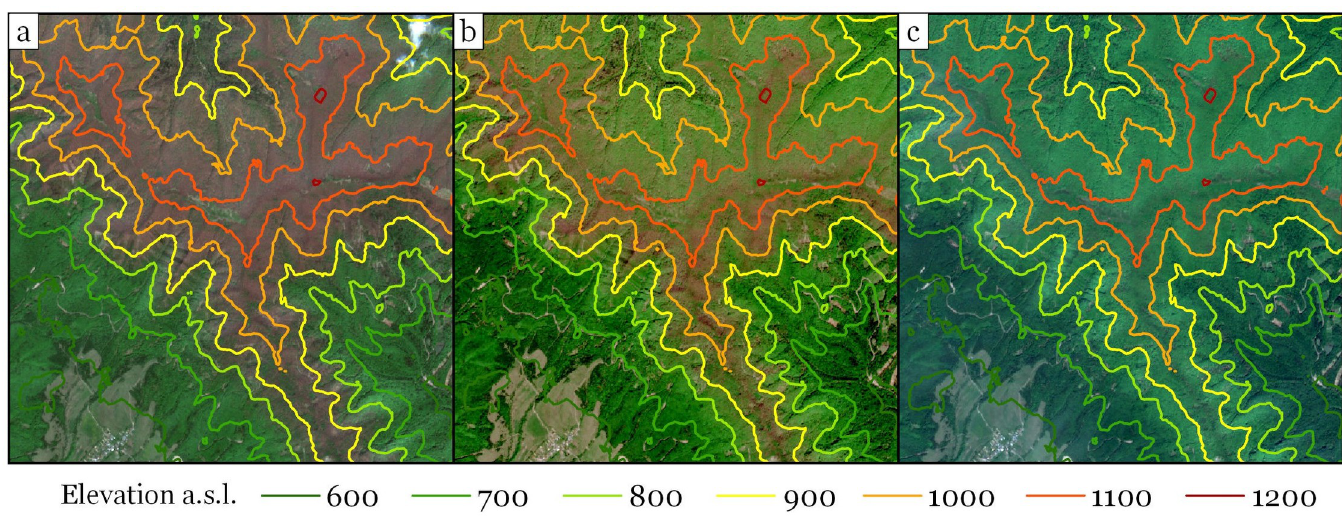
Fig 10. Leaf unfolding in beech stands seen in Sentinel-2 images: a) May 2 nd ; b) May 7 th ; c) May 12 th . The Sentinel-2 imagery was freely downloaded from Copernicus Open Access Hub (https://scihub.copernicus.eu/).